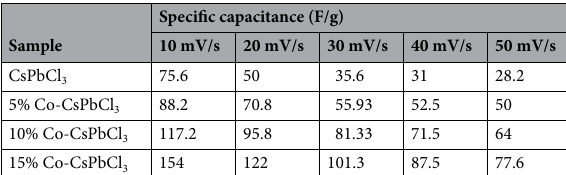
Table 2. The specific capacitance at different Scan rates.